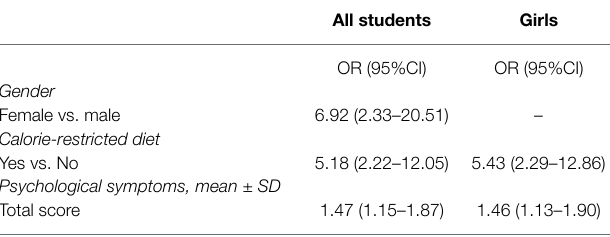
OR, odds ratio; 95%CI, 95% confidence interval.*Stepwise modeling process first involves starting with no variables in the model and ending with the full model (all the predictor variables selected). We considered age, gender, extracurricular activities, skipping breakfast, a calorie-restricted diet, self-esteem, and physical and psychological symptoms as predictor variables. Self-esteem and physical and psychological symptoms were entered as total